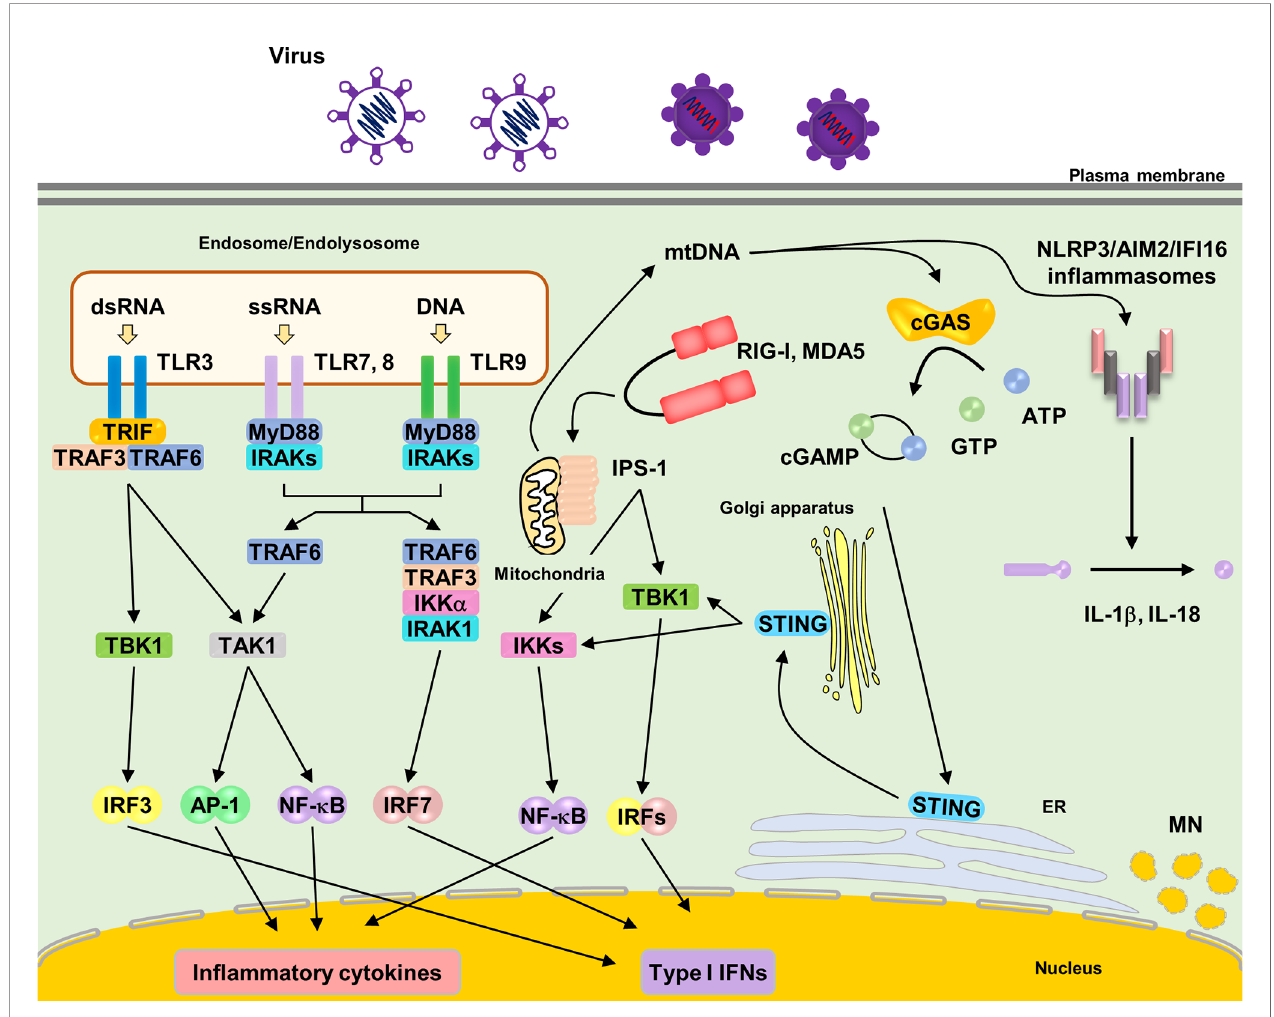
FIGURE 1 | Localization and signaling pathways of nucleic acids sensing TLRs. TLR3, TLR7, TLR8 and TLR9 are localized in endosomes or endolysosomes. Upon ligands ligation of each TLRs, TLR7, TLR8 and TLR9 recruit the adaptor molecules MyD88 to activate downstream signaling pathways. MyD88 recruits IRAKs and